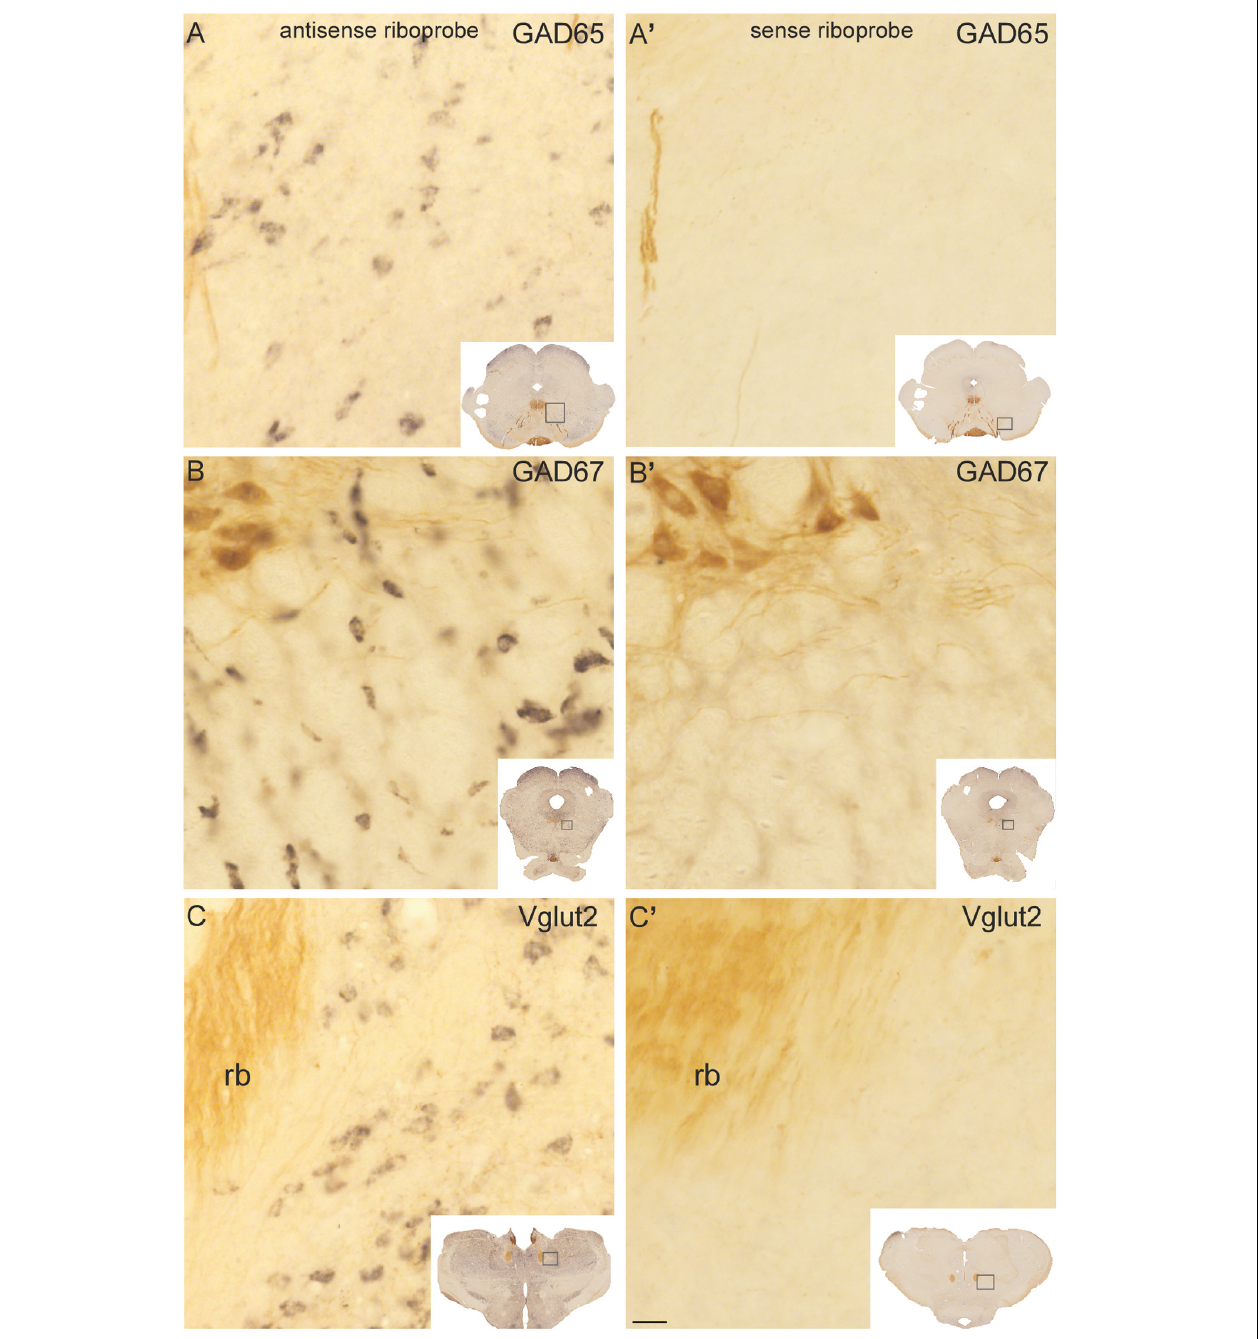
FIGURE 1 | Control experiments for GAD65, GAD67, and Vglut2 riboprobes in sections processed dually for in situ hybridization and ChAT immunocytochemistry. Control sections hybridized with antisense (A–C) riboprobes against GAD65 (A) , GAD67 (B) , and Vglut2 (C) showed a specific black precipitate in neurons, whereas no reaction product was observed in the ones hybridized with any of the sense riboprobes (A’–C’) . ChAT-immunoreactive neurons and fibers (labeled in brown) were readily distinguishable in the trochlear nucleus (PPN; B–B’ , upper left corner) and retroflex bundle (rb; C–C’ , left), respectively. Insets: low magnification images of the control sections, showing within boxes the respective enlarged areas. Scale bar: 20 µ